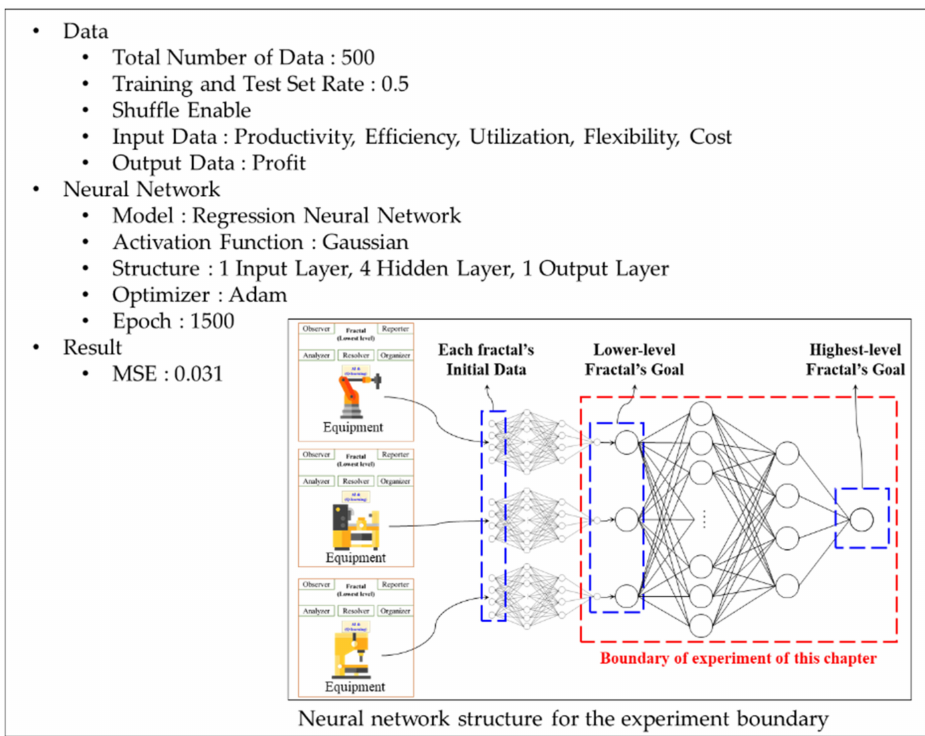
Figure 14. Overview of experiment for the goal decision